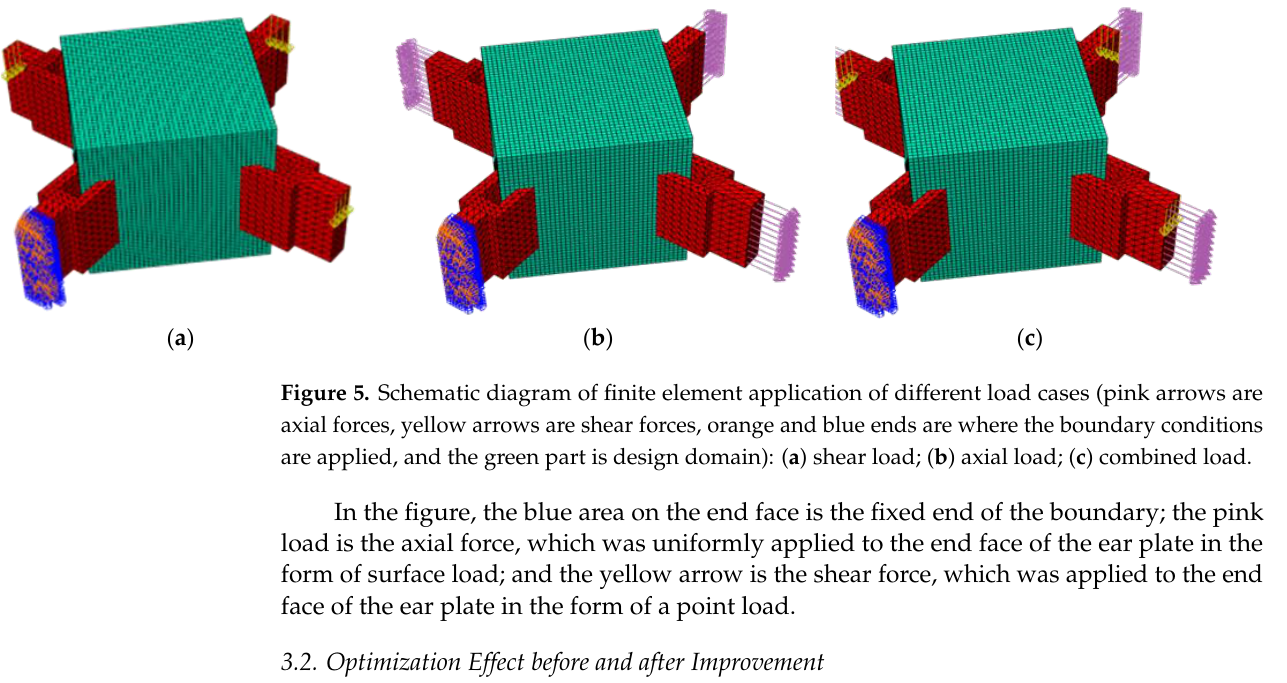
Figure 4. The node model of the finite element mesh division in ABAQUS (the red part is the load application area, and the green part is the design domain).